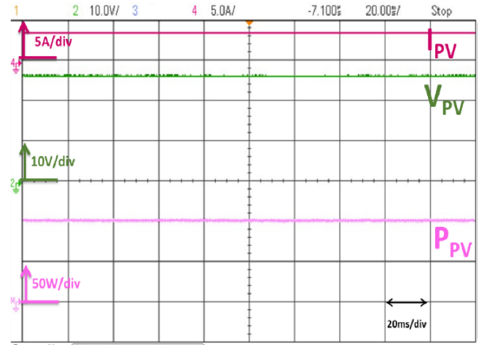
Figure 11. PV voltage current and power for the proposed fixed-frequency predictive MPPT (P max = 100 W) (Ch2 (green) is PV voltage, Ch4 (pink line) is the PV current), the PV extracted power (lavender line).